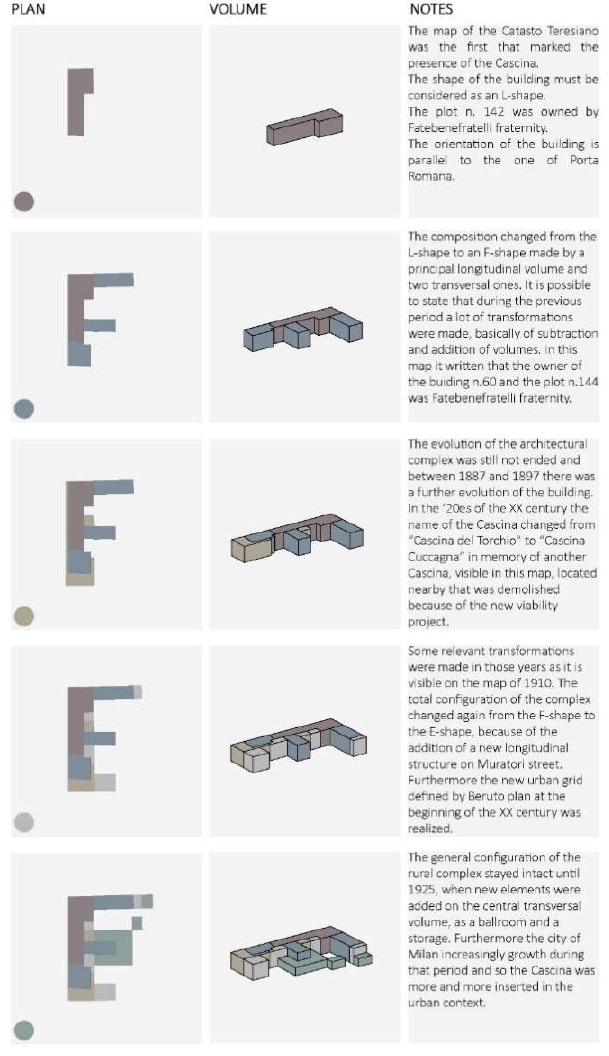
Figure 4. Historic survey of construction phases.